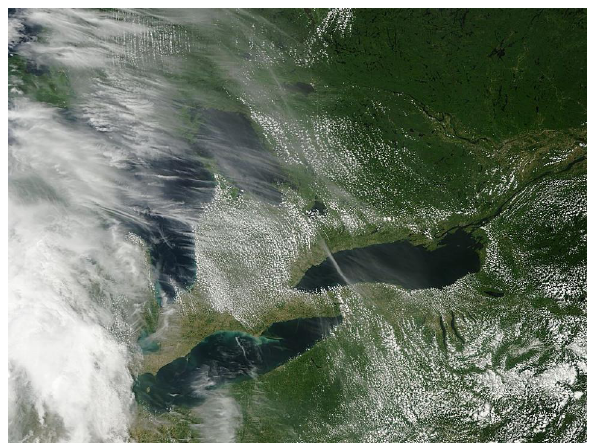
Fig. 12. Terra MODIS true colour image at 1km resolution over the CORALNet Egbert site on 27 June 2011. Notice the smoke, more easily visible over the water surface, at the leading edge of the cloud system.